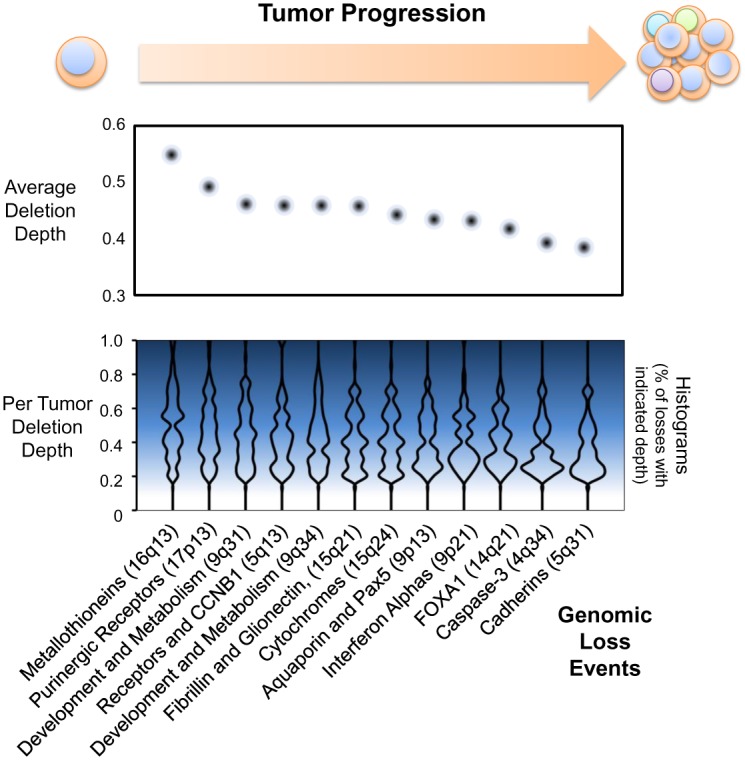
Temporal loss of chromosome regions in PMCH tumor progression.Histograms of copy number alteration magnitudes are generated from tumors with a -0.2 or greater decrease in genomic signal for the indicated genomic regions; results are mirrored for emphasis in this graphical representation. Dots indicate median magnitude, or “deletion depth”, of copy number loss across all tumors with the indicated loss event. Based upon depth of loss (see methods) the cadmium response metallothionein genes appear to be lost prior to other copy number events (p<1x10-11 compared to all other regions, p<0.03 compared to cytoband 17p13).